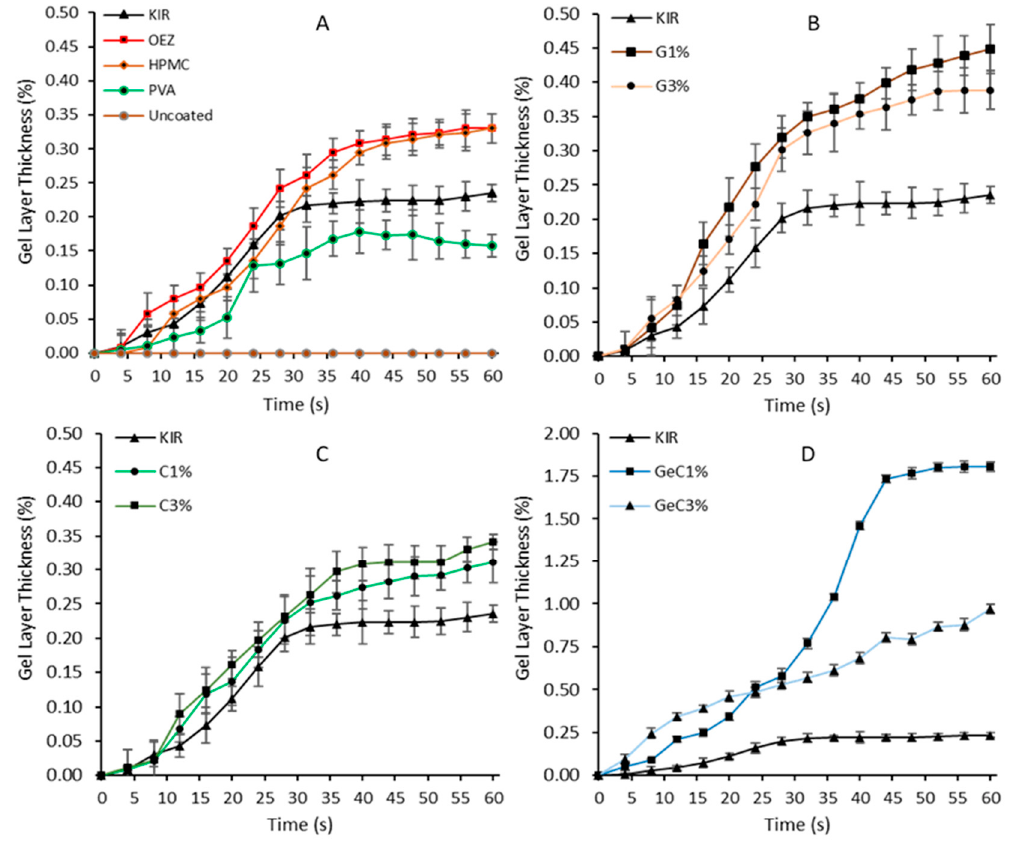
Figure 2. Quantitative analysis of the axial gel layer thickness over time of film-coated tablets, as calculated using a high-speed recording camera with macro lens and imaging software for 60 at 4 s intervals. Uncoated tablets commenced disintegration and did not swell when immersed in water. Graph ( A ) represents commercial grade film coats, gelatin formulations are shown in graph ( B ), λ -carrageenan shown in graph ( C ), gelatin: λ -carrageenan combination formulations are represented in graph ( D ).